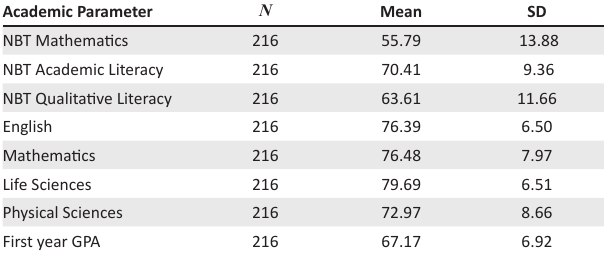
TABLE 3: Descriptive profile of academic proficiency levels of cohort